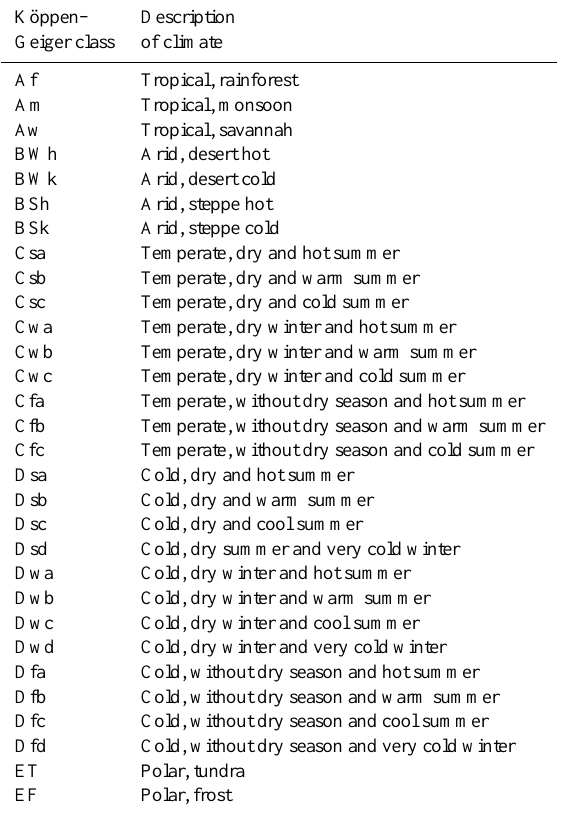
Table 5. Köppen–Geiger climate classification (adapted from Peel et al.,